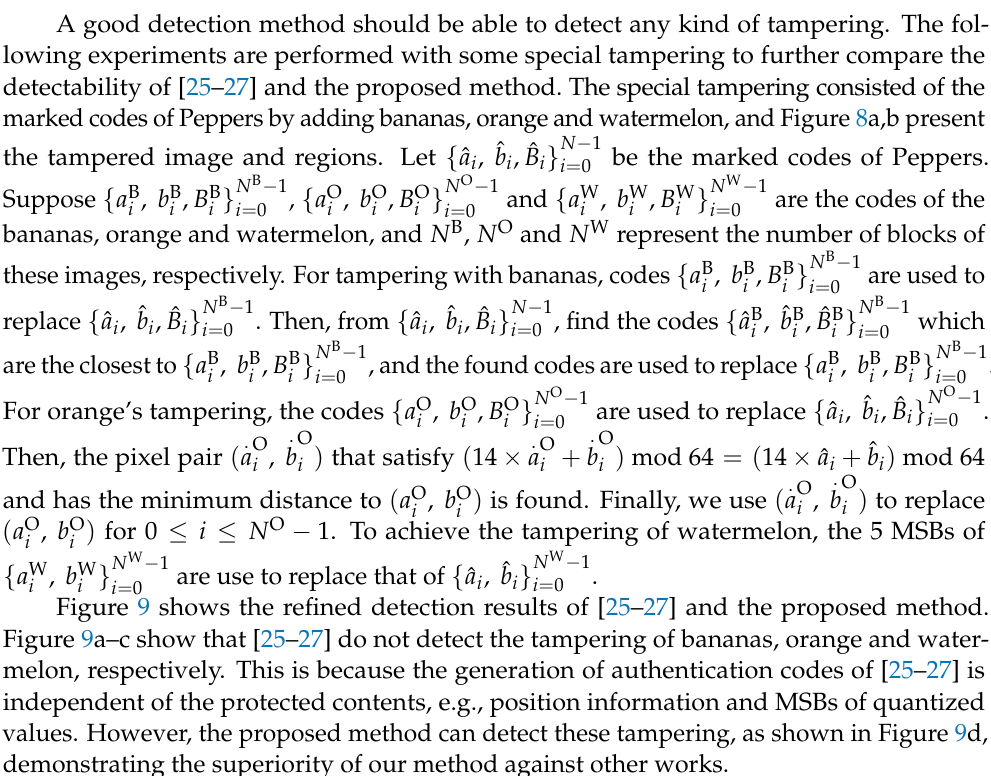
result of [27]; ( f ) Detection result of the proposed method.